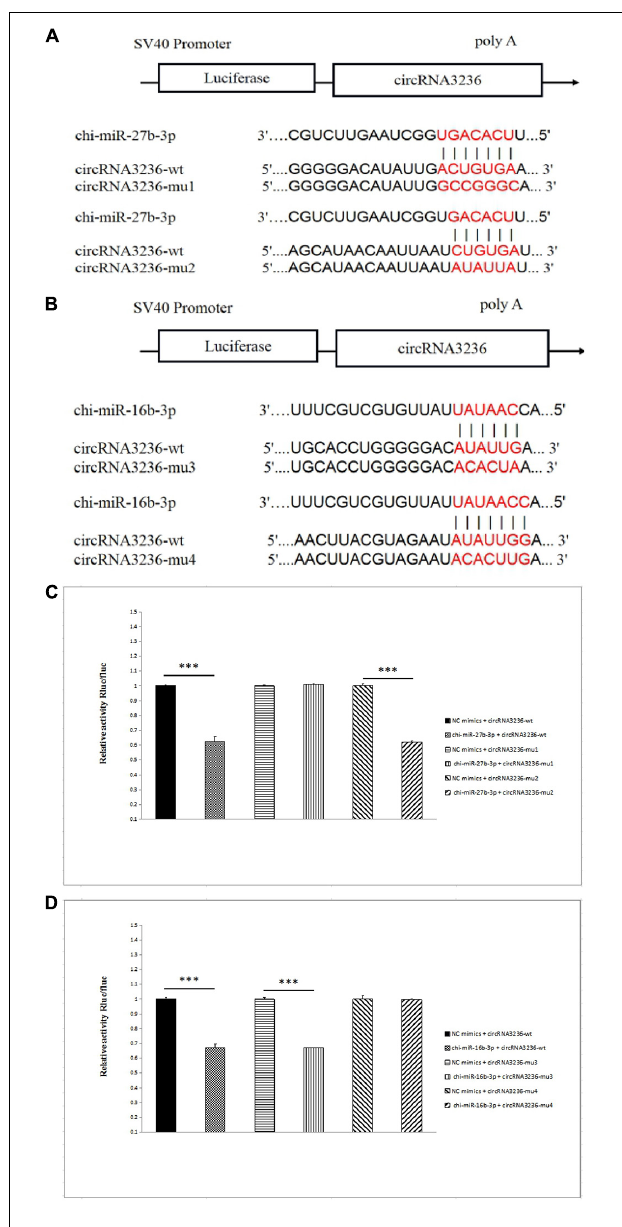
FIGURE 7 | CircRNA3236 sponged with chi-miR-27b-3p andchi-miR-26a-3p. (A) The predicted binding site and mutated site of chi-miR-27b-3p in circRNA3236. (B) The predicted binding site and mutated site of chi-miR-16a-3p in circRNA3236. (C) Detection of interaction between circRNA3236 and chi-miR-27b-3p by dual luciferase reporter gene assay. (D) Detection of interaction between circRNA3236 and chi-miR-16b-3p by dual luciferase reporter gene assay. ∗∗∗ P < 0.001 shows that the difference is extremely